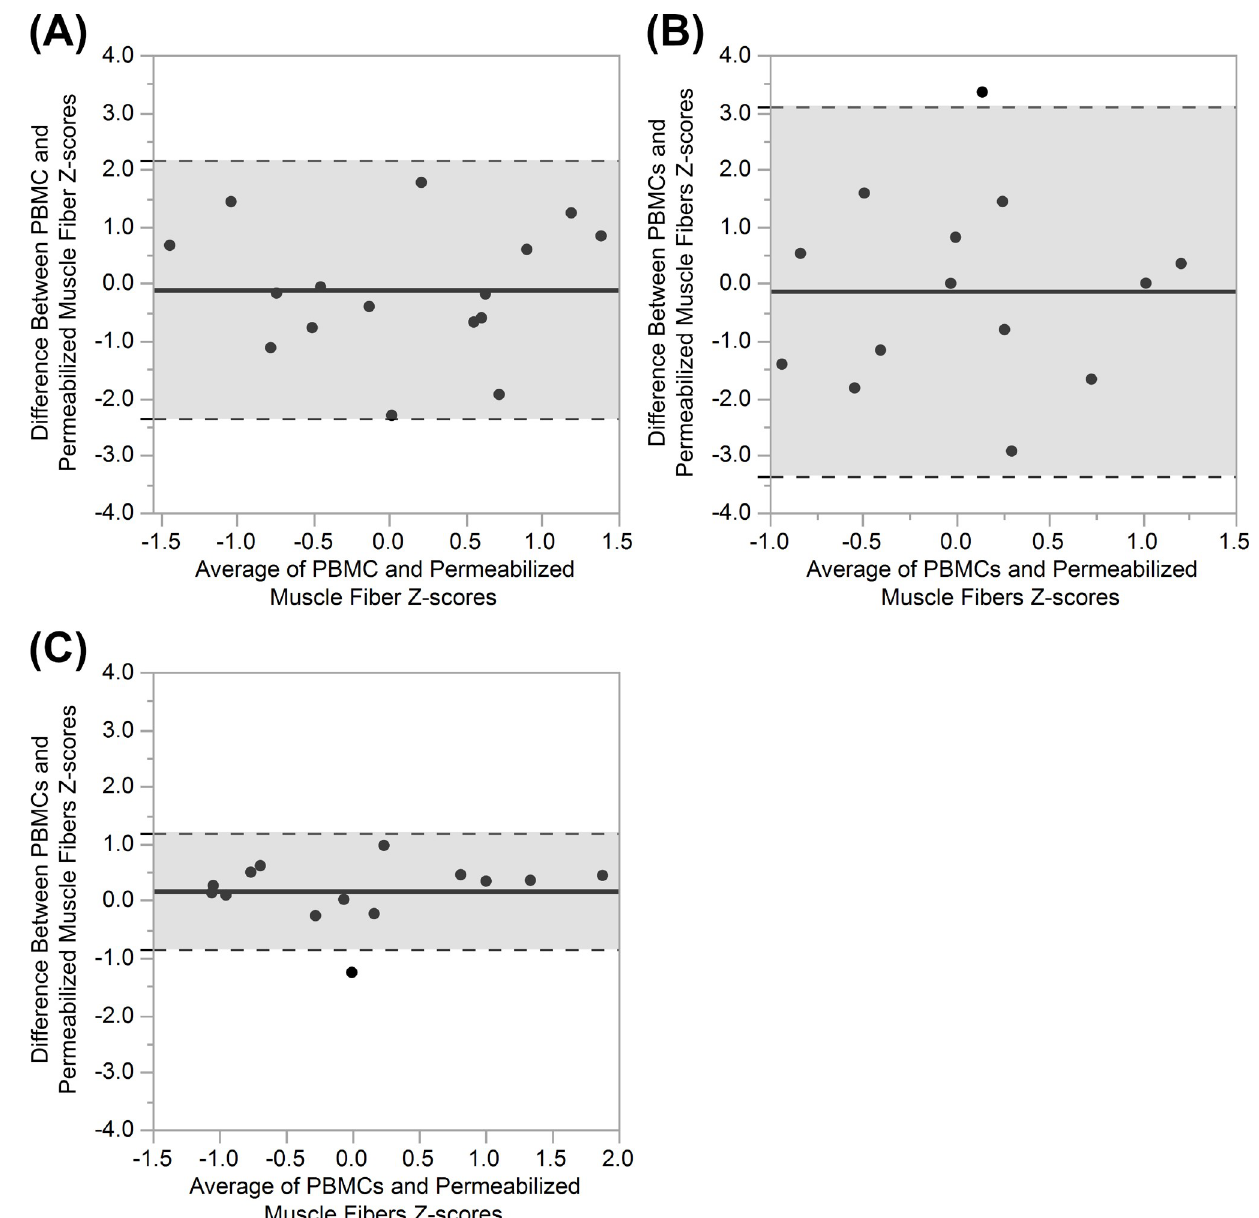
Fig 3. Agreement between PBMCs and permeabilized skeletal muscle fiber measures of mitochondrial capacity. Bland-Altman plots of normalized high resolution repirometry of PBMC and normalized permeabilized muscle fiber indices of mitochondrial respiratory capacity in individuals with SCI for mitochondrial complexes (A) I (n = 16), (B) II (n = 14), and (C) IV (n = 14). Solid black line represents the mean difference; the greyed region between the dashed black lines represents the 95% limits of